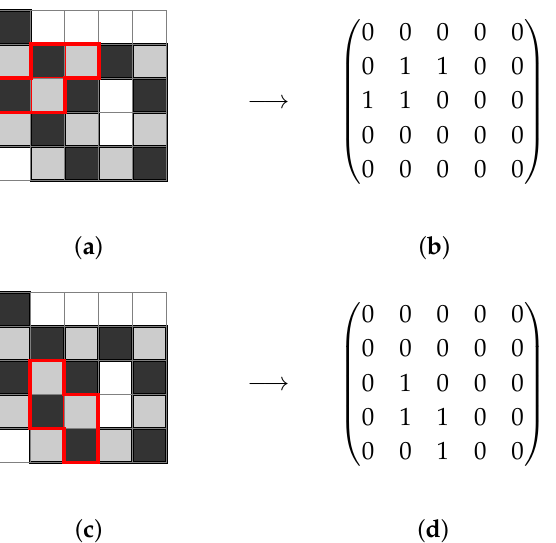
; ( b ) binary matrix (cid:98) A 1,1 ; ( c ) second placement of P + 1